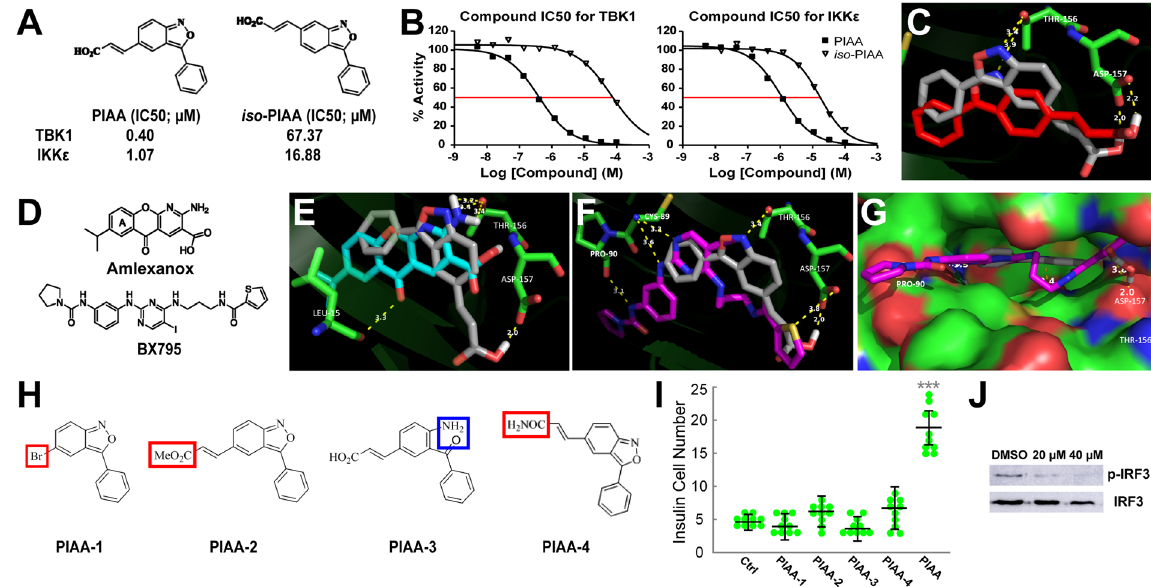
Figure 2. Kinase profiling, molecular docking, and structure-activity relationship analyses reveal selectivity of the TBK1/IKK ε inhibitors. ( A , B ) Chemical structures and kinase profiling of PIAA and iso -PIAA. Dose responses of PIAA and iso -PIAA were generated to determine the potency of the inhibitors (IC 50 ). ( C ) Ball and stick model of PIAA (grey) and iso -PIAA (red) docked into the binding pocket of TBK1. PIAA adapts a docked pose that has its isoxazole nitrogen and carboxylate moieties engaged in stronger interactions, relative to the same moieties on iso -PIAA, with THR-156 and ASP-157 at the active site of TBK1. ( D ) Chemical structures of amlexanox and BX795. ( E – G ) Molecular docking simulations showing interactions of TBK1/IKK ε -Is and TBK1. Ball and stick model of PIAA (grey), amlexanox (blue), and BX795 (purple) docked into the binding pocket of TBK1 ( E and F ). Space filling model of PIAA (grey) and BX795 (purple) docked into the binding pocket of TBK1 ( G ). The core moieties of PIAA, amlexanox, and BX795 all bound within an unvaried region of the kinase domain of TBK1, while the urea moiety of BX795 extends toward the outer rim of the TBK1 kinase domain and interacts with the carbonyl group of Pro-90. Specifically, the carboxylate moieties of PIAA and amlexanox are placed next to the carboxylate side chain of ASP-157 buried in the TBK1 active site, forming a strong low-barrier H-bonding between these two carboxylate groups. ( H ) Chemical structures of four PIAA analogs. The moieties that were replaced and different from the original PIAA structure are marked in red (PIAA-1, PIAA-2, and PIAA-4) or blue (PIAA-3). ( I ) Quantification of the number (mean ± SD) of total regenerated β -cells at 48 hpa treated with DMSO, PIAA-1, PIAA-2, PIAA-3, PIAA-4, and PIAA,